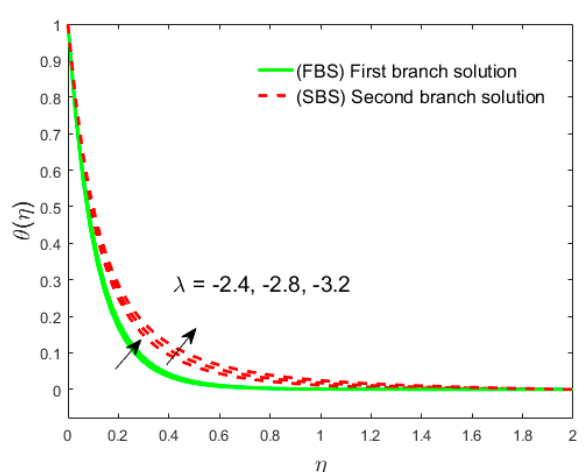
Figure 17. Influence of